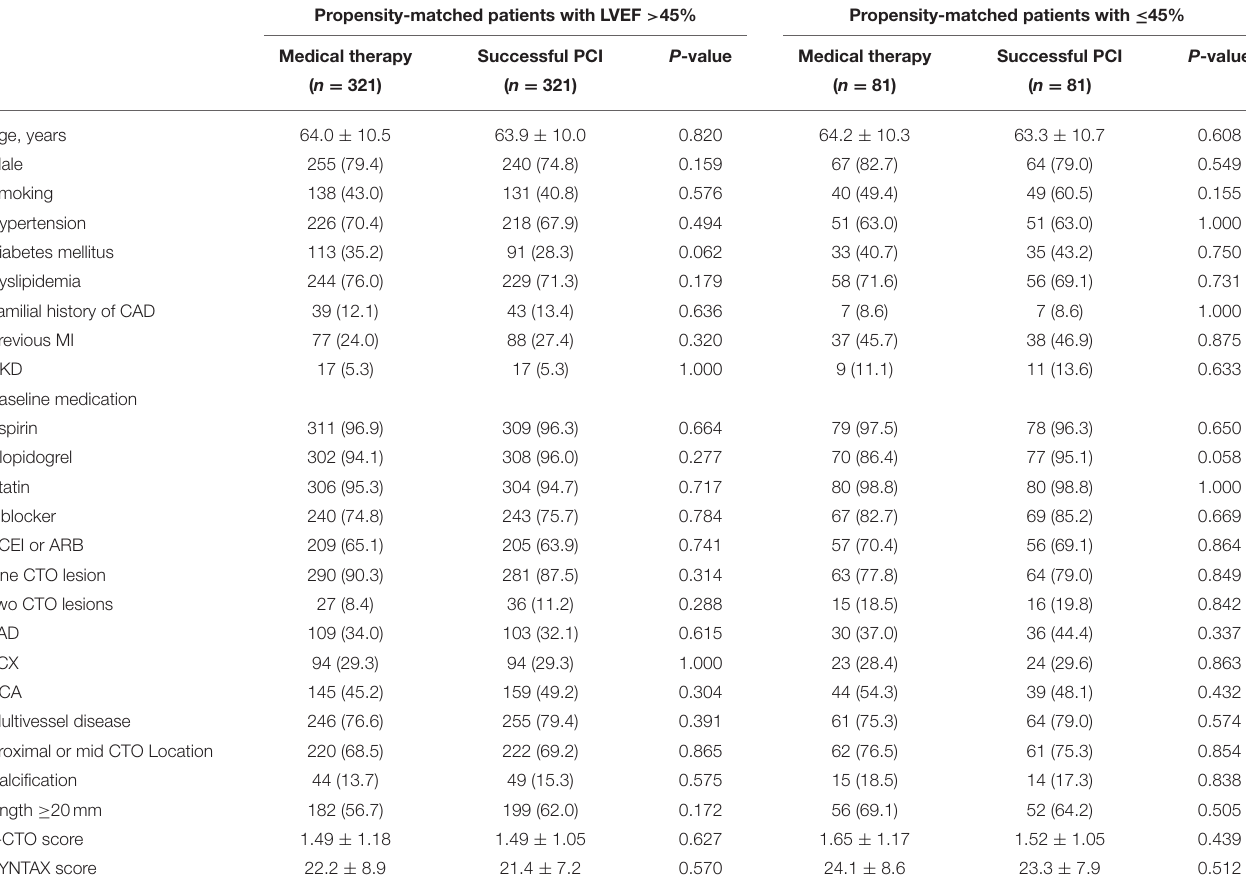
TABLE 3 | Baseline clinical, angiographic, and procedural characteristics of propensity-matched patients with and without left ventricular systolic dysfunction stratified according to management. Propensity-matched patients with LVEF > 45% Propensity-matched patients with ≤ 45% Medical therapy Successful PCI P -value Medical therapy Successful PCI